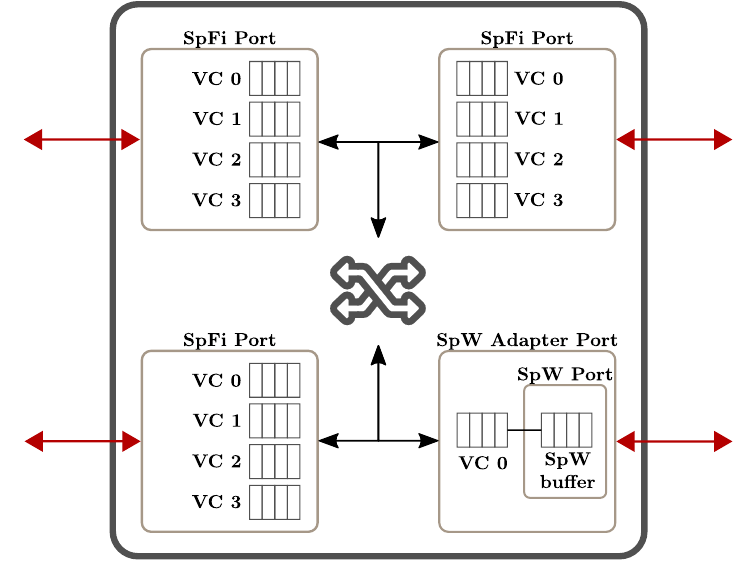
Figure 4. Routing Switch with a SpaceWire Adapter